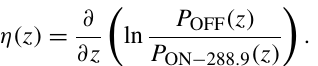
Figure 9. Comparison between the TMTOL very near-range re- ceiver retrieval (solid, blue), an ozonesonde tethered system (dots, black) and a surface ozone monitor (dot, blue). Lidar retrieval 1 σ uncertainty is shown (gray,